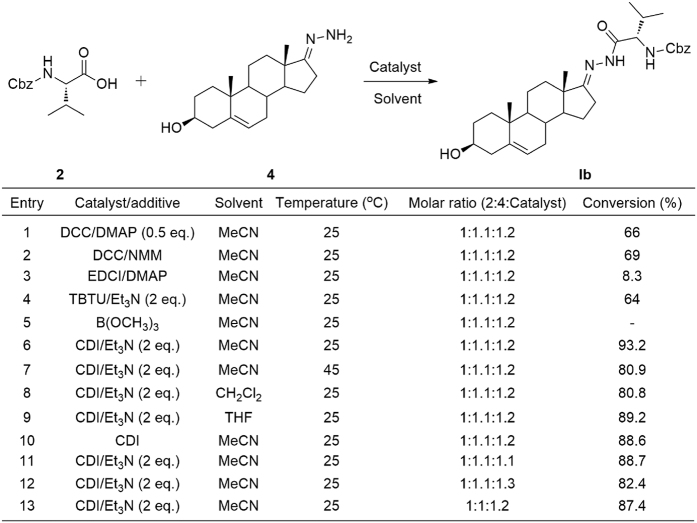
Reaction conditions screening.